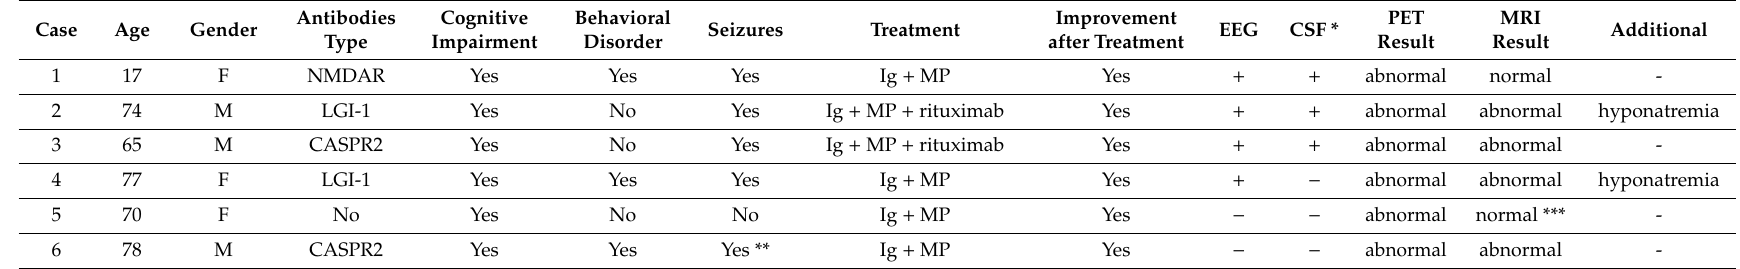
Table 1. Clinical data and